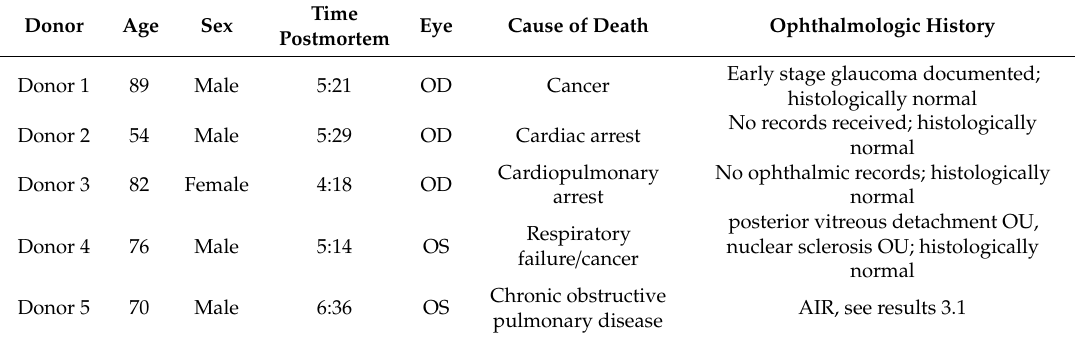
Table 1. Sample information from the donor eyes utilized in this study. Note that donor eyes 1–3 serve as controls for the current study and have been previously published